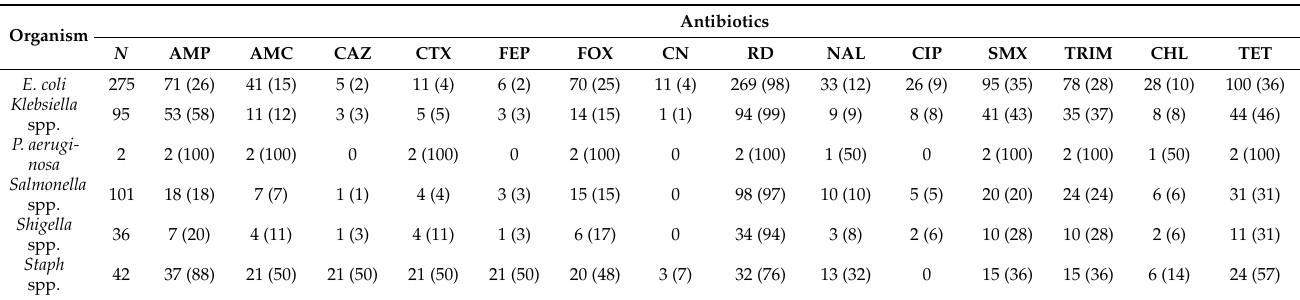
Table 2. Table showing the antimicrobial resistance profiles in recovered isolates.